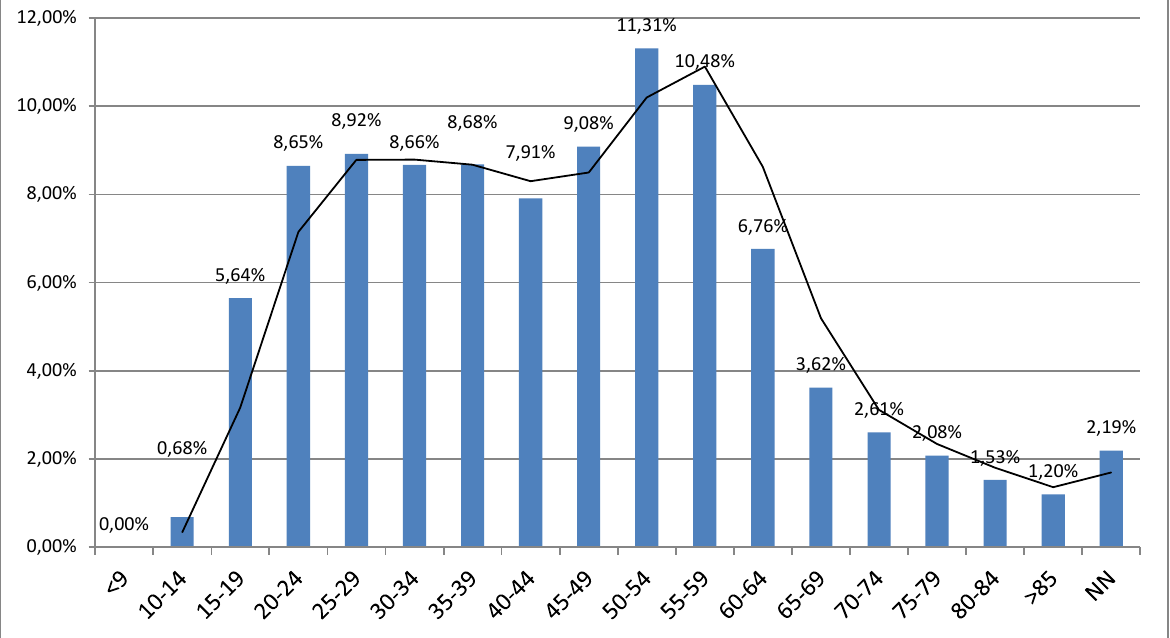
Figure 2. Percentage of individuals with certain age range of all the individuals making a suicide attempt within one year (average for Poland in